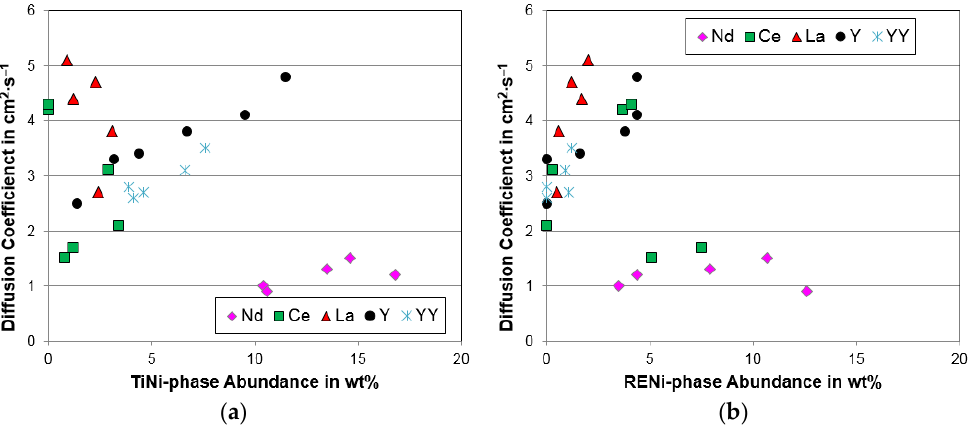
Figure 14. Correlations between diffusion coefficient and ( a ) TiNi phase abundance; and ( b ) RENi phase abundance.